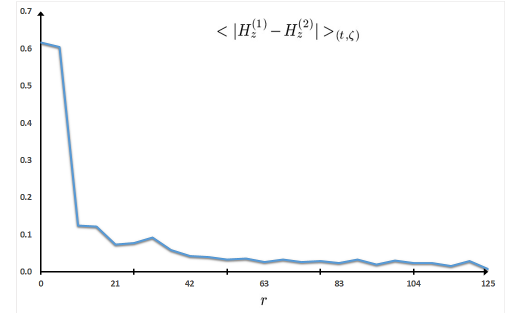
Figure 2. r -dependency of the average < | H (1) z − H (2) z | > ( t,ζ ) (c) Interpretation of the coefficient (cid:98) β ζ and exp ( (cid:98) β ζ ). As we have (cid:98) β ζ = − 0 .